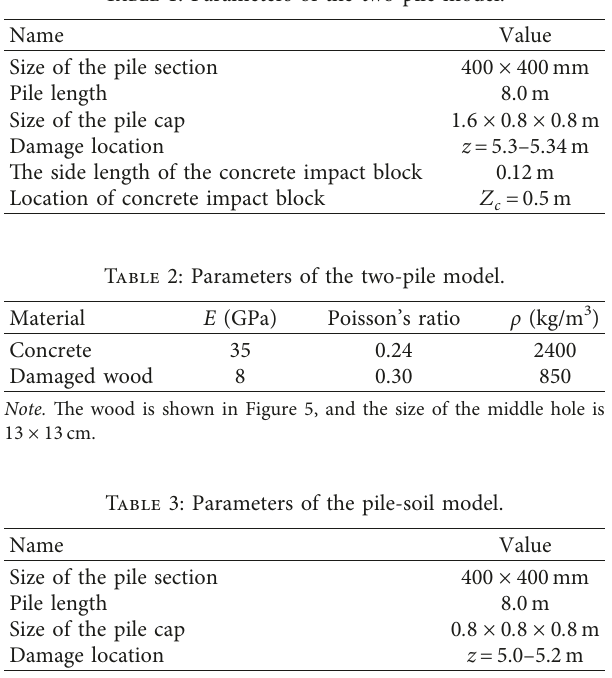
Figure 4: Computational domains. (a) The two-pile model. (b) The pile-soil model. Table 1: Parameters of the two-pile model.